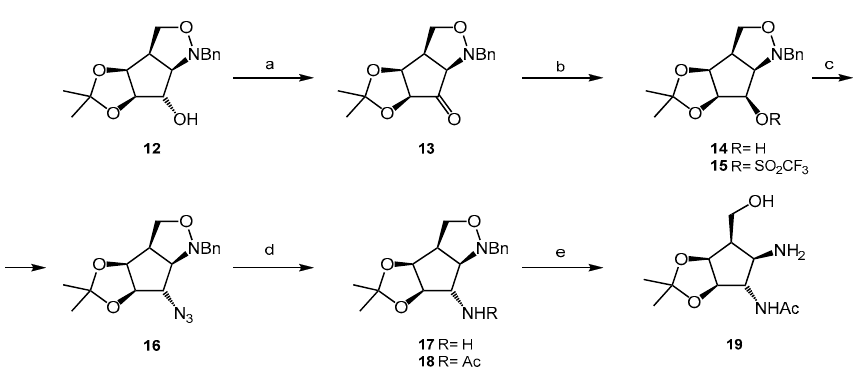
Table 1. Inhibitory activities of new compounds with N -acetylhexosaminidases.